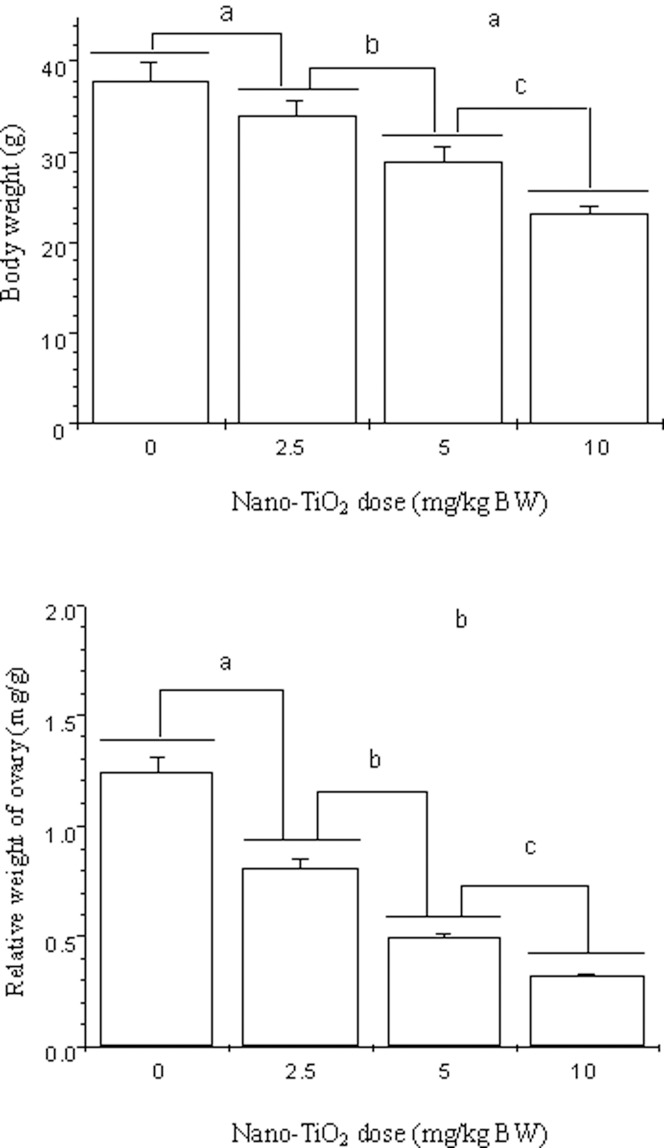
Changes of body weight and relative weight of ovary of mice caused by intragastric administration of nano-TiO2 for 90 consecutive days.Different letters indicate significant differences between groups (p<0.05). Values represent means ± SE (N = 10).